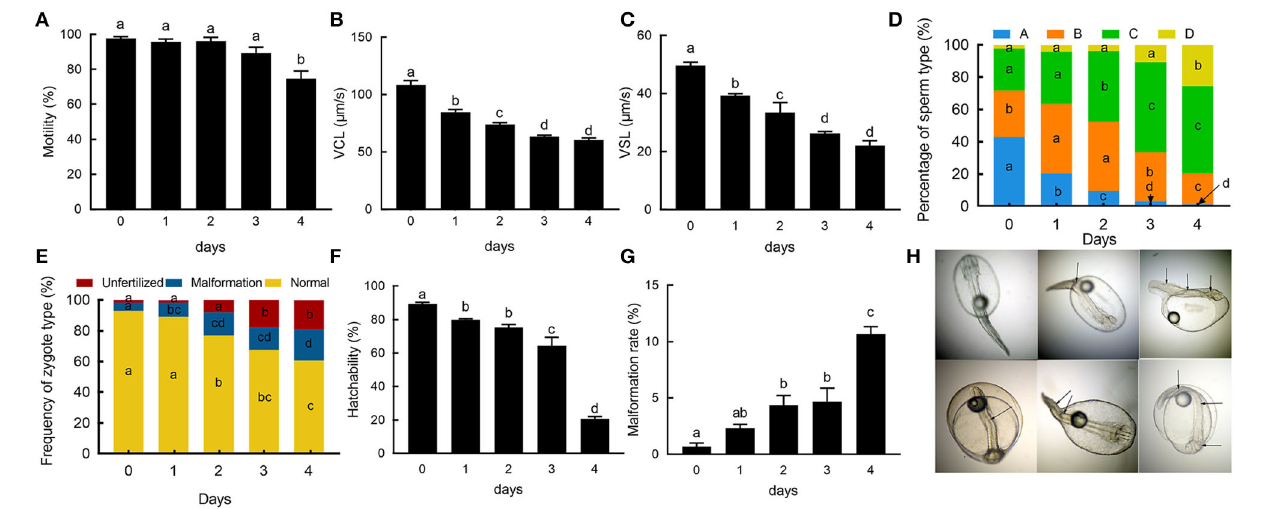
FIGURE 1 | The sperm changes during cold storage. (A) The changes of sperm motility during cold storage. (B) The changes of curvilinear velocity (VCL) of sperm during cold storage. (C) The changes of straight-line velocity (VSL). (D) The rate of changes of the sperm type during cold storage. Blue, orange, green, and yellow indicate “A, B, C, and D” type spermatozoa, respectively. (E) The rate of changes of zygote types. Yellow, blue, and red indicate normal, malformed, and unfertilized zygote. (F) Changes of hatchability. (G) Malformation rate of fry using sperm on different days; (H) Normal and malformed fries. Different letters indicate the significant difference among groups; Arrows point to the deformity of